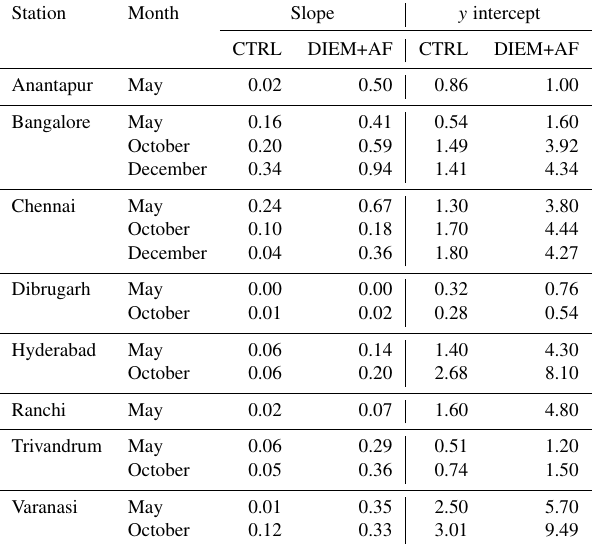
Table 1. Statistics (slope of the best-fit line and the y intercept) of the comparison between the daily-mean values of the observed and modeled NSBC shown in Fig.